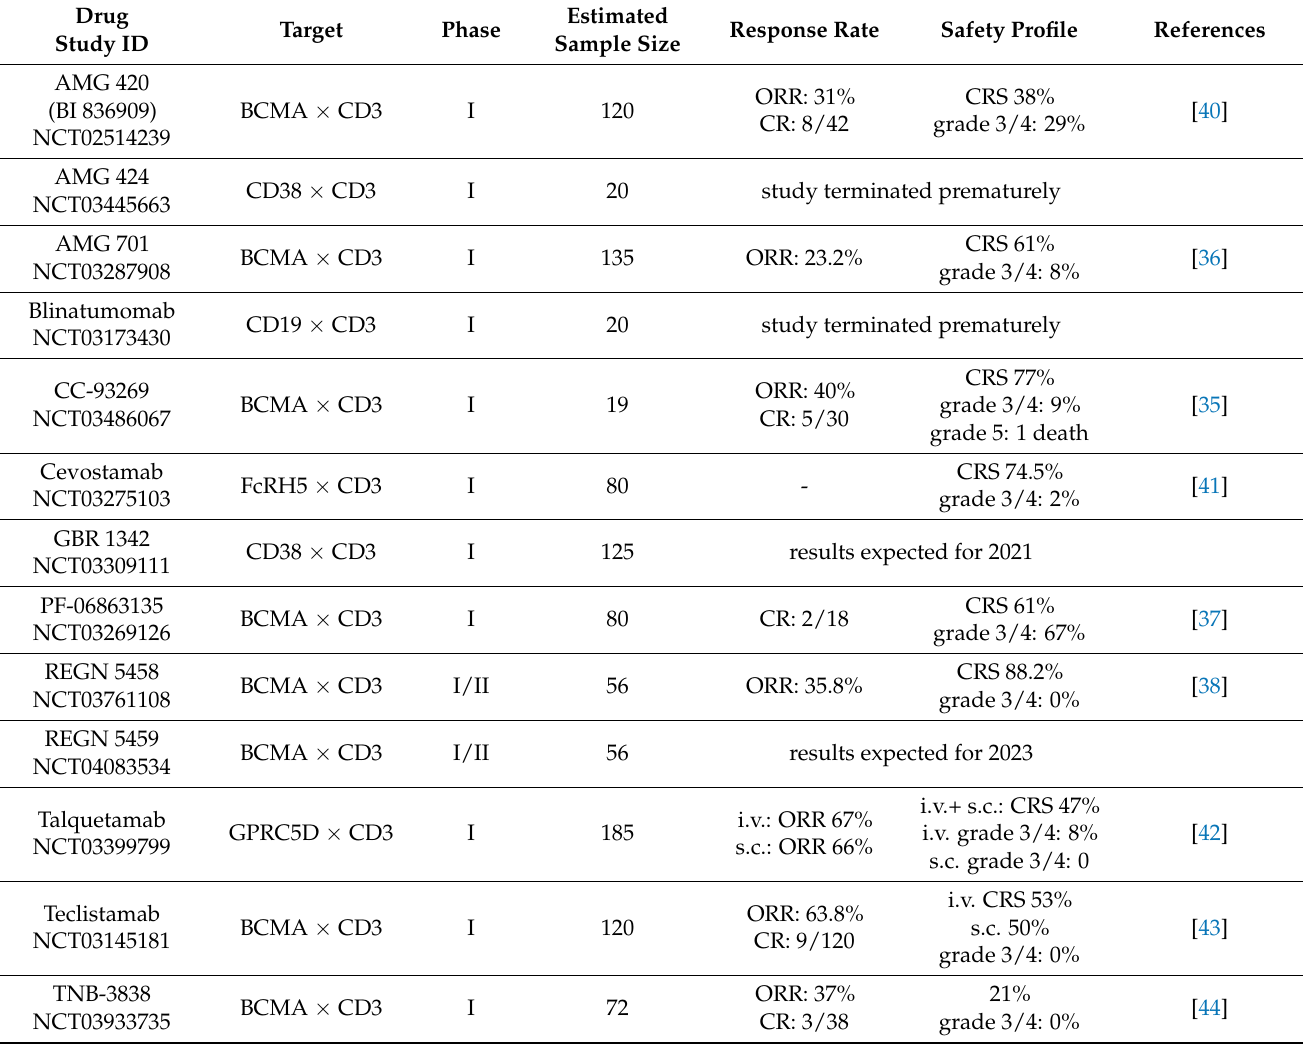
Table 2. Overview of clinical trials investigating bispecific